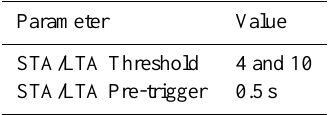
Table 5. Input parameter values used in the MATLAB-based code for the automatic event